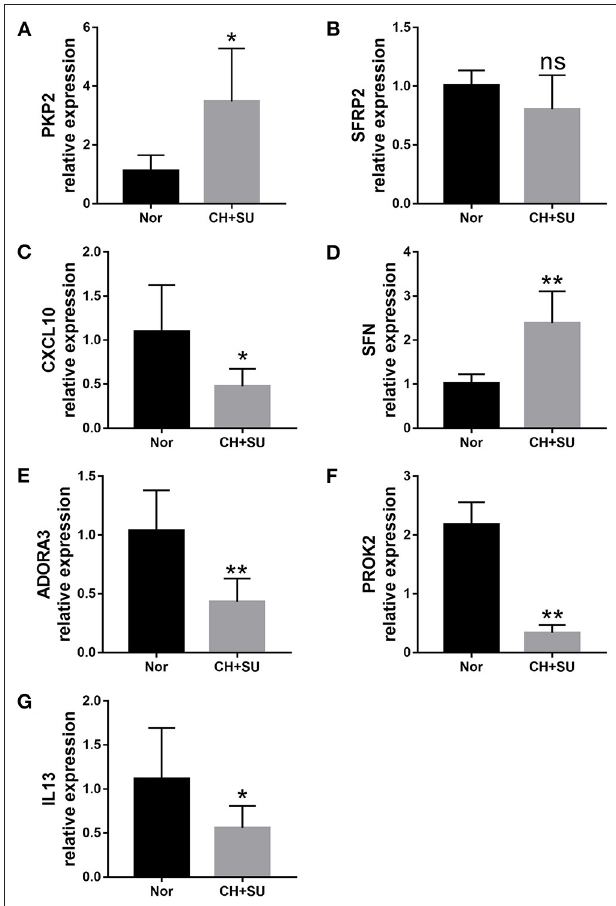
FIGURE 9 | Validation of seven differently expressed key genes through RT-PCR in the lungs from CH + SU or Nor mice. Expression of PKP2 (A) , ADORA3 (B) , PROK2 (C) , IL-13 (D) , CXCL10 (E) , SFN (F) , and SFRP2 (G) in CH + SU mice compared with Nor controls. PKP2, plakophilin-2; ADORA3, adenosine A3 receptor; PROK2, prokineticin 2; IL-13, interleukin-13; SFN, stratifin; SFRP2, secreted frizzled-related proteins. n = 6 in each group. * p < 0.05, ** p < 0.01 vs. Nor group. All graphs are shown as mean ±